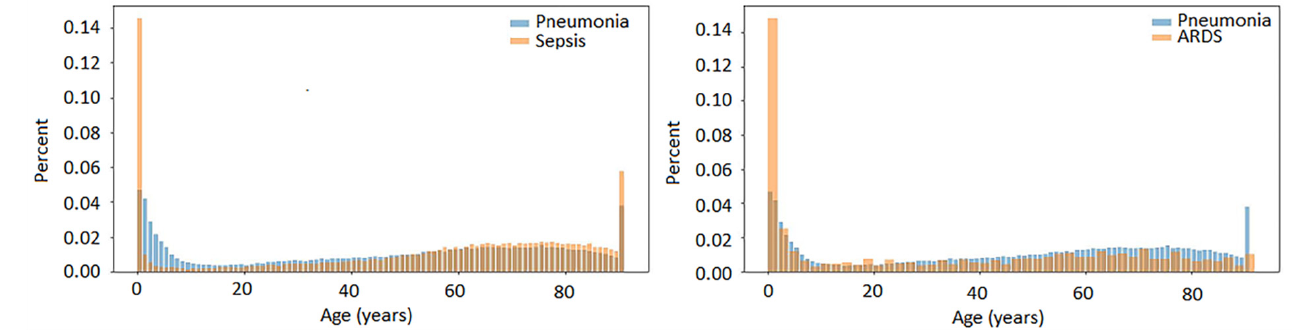
Figure 2. Temporal clinical data for pneumonia, sepsis and ARDS. Concept-age distributions.